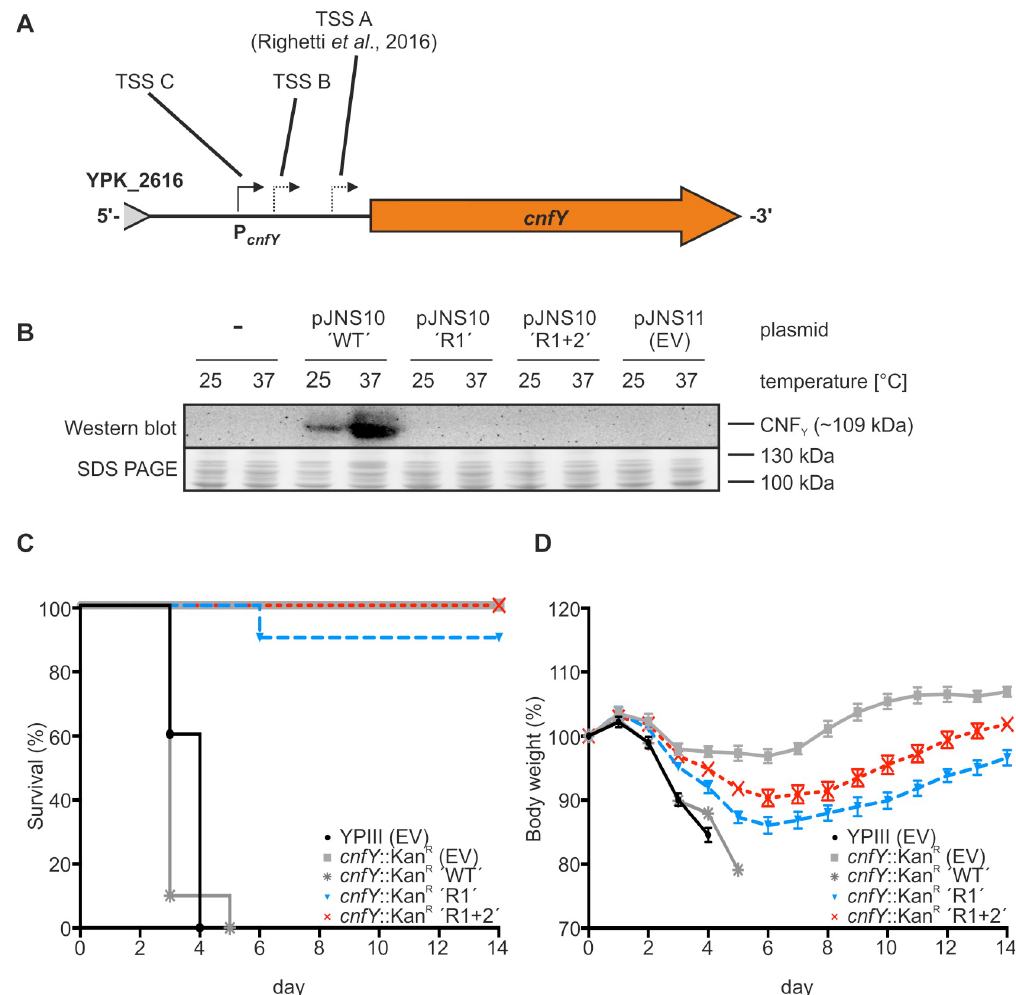
Fig 8. Stabilizing point mutations within the cnfY RNAT affect virulence of Y . pseudotuberculosis . (A) Schematic representation of the cnfY promoter region (P ) and the coding region which are part of the pJNS10 complementation cnfY vector [20]. Transcriptional start sites (TSS) identified in a previous study [18] and in this study (see Fig 2) are marked by arrows. (B) Y . pseudotuberculosis Δ cnfY (YP216) cells without vector or harboring vector pJNS10 ( cnfY complementation vector; [20]), pJNS10 R1 ( cnfY complementation harboring mutation R1; pBO6503), pJNS10 R1+2 ( cnfY complementation vector harboring mutation R1+2; pBO6504), and pJNS11 (empty vector) were grown to exponential growth phase (OD 600 = 0.5). Afterwards, samples were taken for SDS-PAGE as well as Western blot analysis with an antibody against CNF Y . The experiment was performed at least in triplicate. (C) Survival and (D) body weight of BALB/c mice (n = 10/strain) was monitored for up to 14 days after oral infection via food pellets with 2x10 9 CFU of either Y . pseudotuberculosis YPIII harboring the empty vector pJNS11 (black line + black dots) or the cnfY mutant YP147 ( cnfY :: Kan R ) harboring the empty vector pJNS11 (grey line + grey squares) or the cnfY complementation vector pJNS10 (pP : cnfY + ) including either the wild cnfY type (grey line + grey asterisk), the R1 (blue line + blue triangles), or the R1+2 (red line + red crosses) variant of the cnfY RNAT. Displayed data represent results from two individual experiments (biological